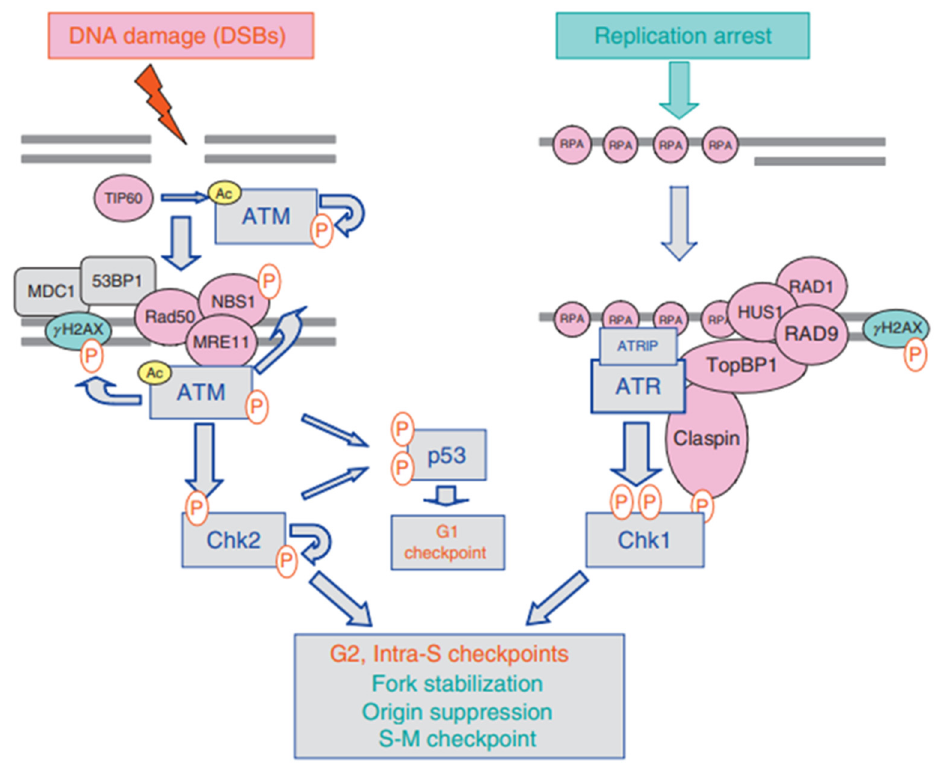
Figure 6. Activation of the ATM-Chk2 and ATR-Chk1 pathways. The ATM-Chk2 and ATR-Chk1 pathways are activated selectively by DSBs and tracts of ssDNA complexed with RPA, respectively. Phosphorylation events are indicated by (P) in red and acetylation by (Ac) in yellow. Adapted from [111].